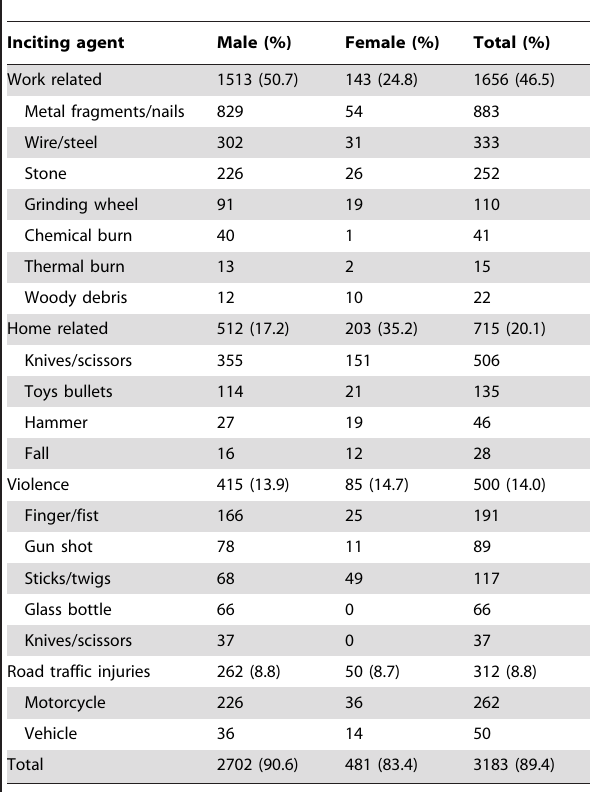
Table 2. Causative agents of the most frequent injury categories by